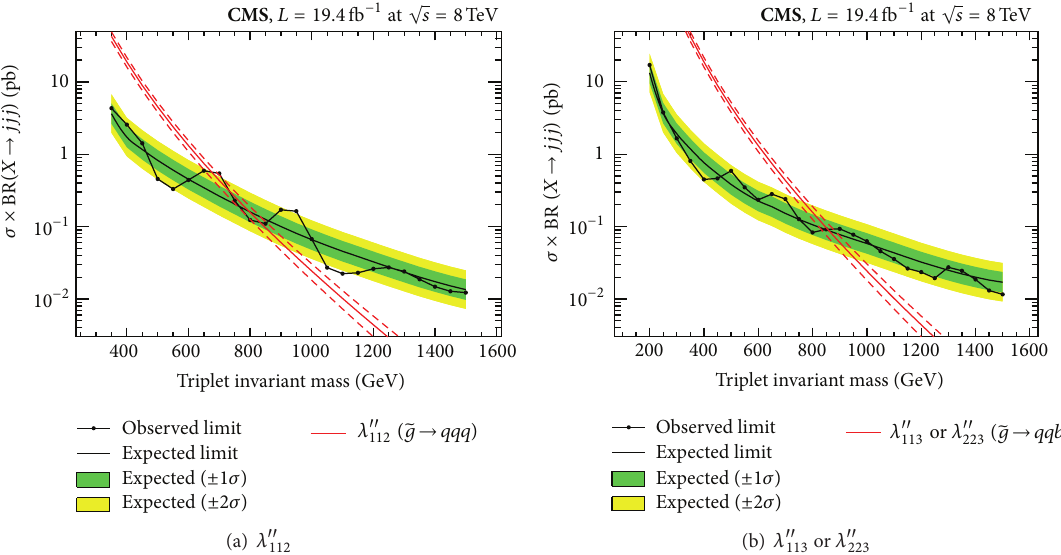
Figure 16: Observed and expected 95% CL cross section limits as a function of mass for the inclusive (a) and heavy-flavor searches (b). The limits for the heavy-flavor search cover two mass ranges, one for low-mass gluinos ranging from 200 to 600 GeV, and one for high-mass gluinos covering the complementary mass range up to 1500GeV (from [45]).